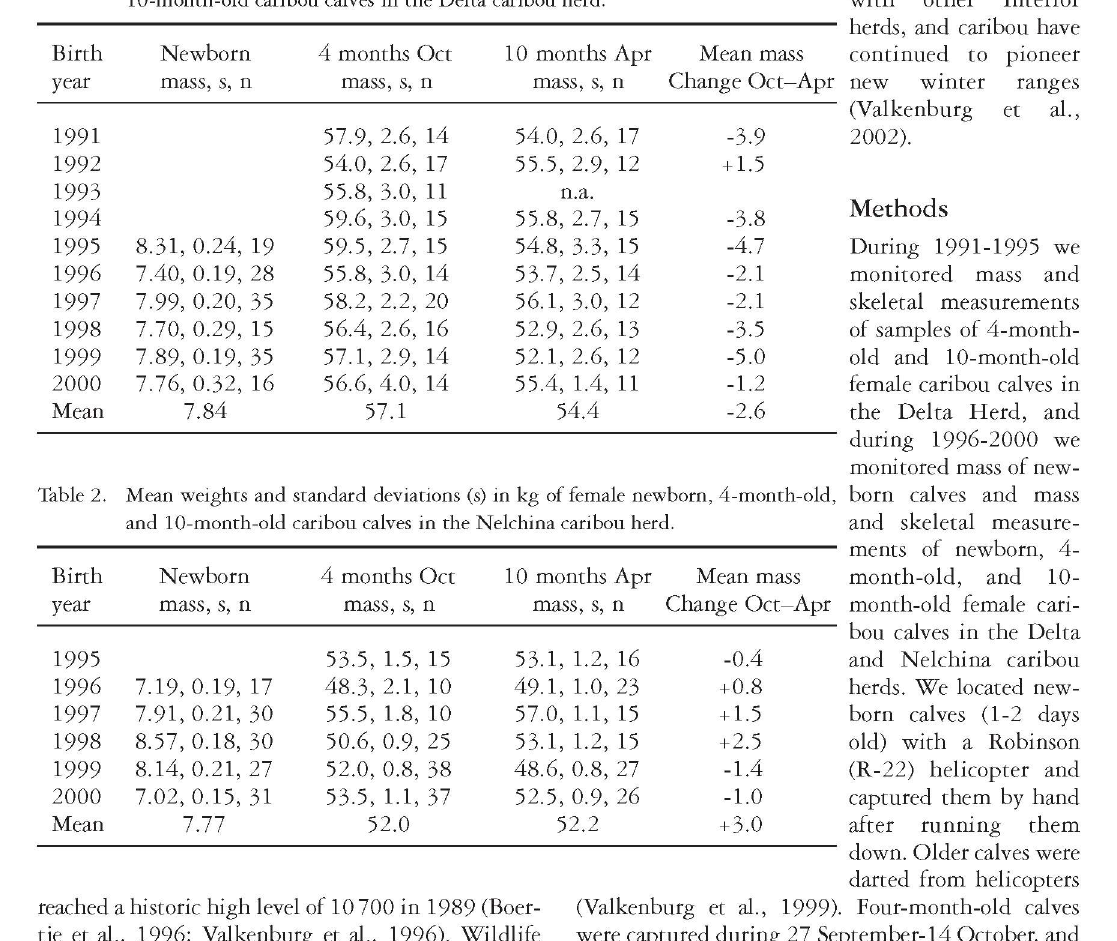
relatively low compared with other